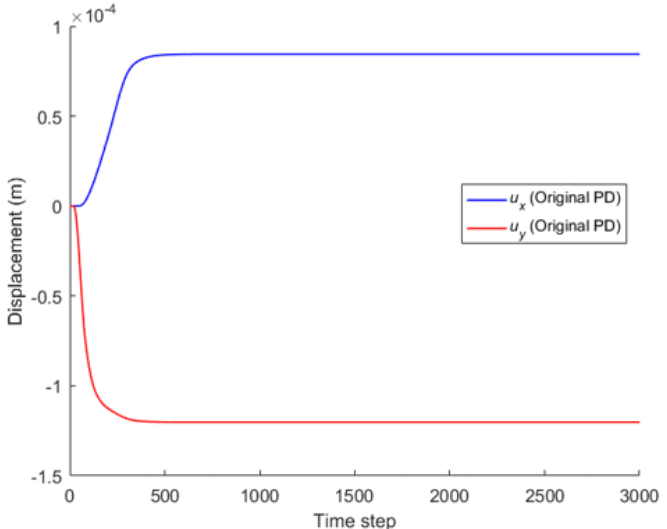
Figure 7. Convergence of original PD with time step.